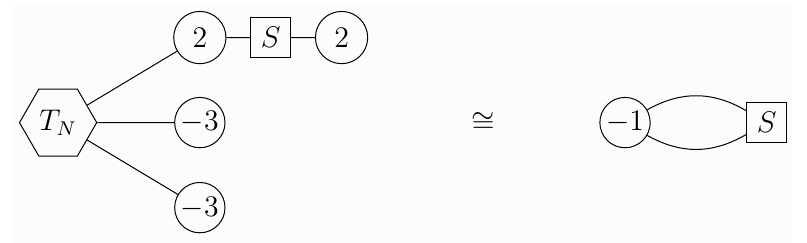
Figure 15 . A duality suggested by two equivalent descriptions of a space as a Seifert manifold or as a torus bundle. Recall that in our notation the numbers in the nodes are the CS